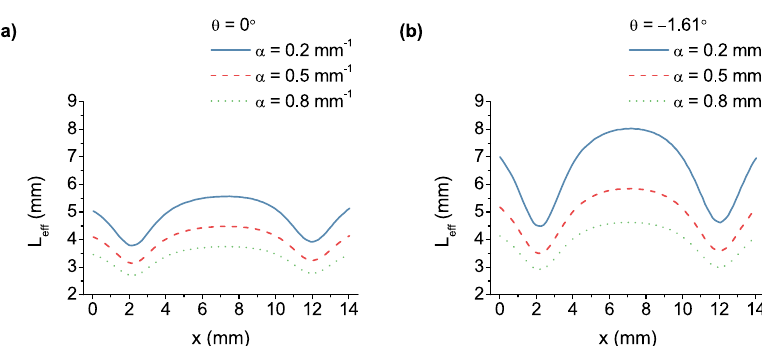
Figure 5. Effective optical absorption path length values calculated along the length of the filter for the absorption coefficients of 0.2mm − 1 , 0.5mm − 1 and 0.8mm − 1 at ( a ) normal and ( b ) oblique incidence.